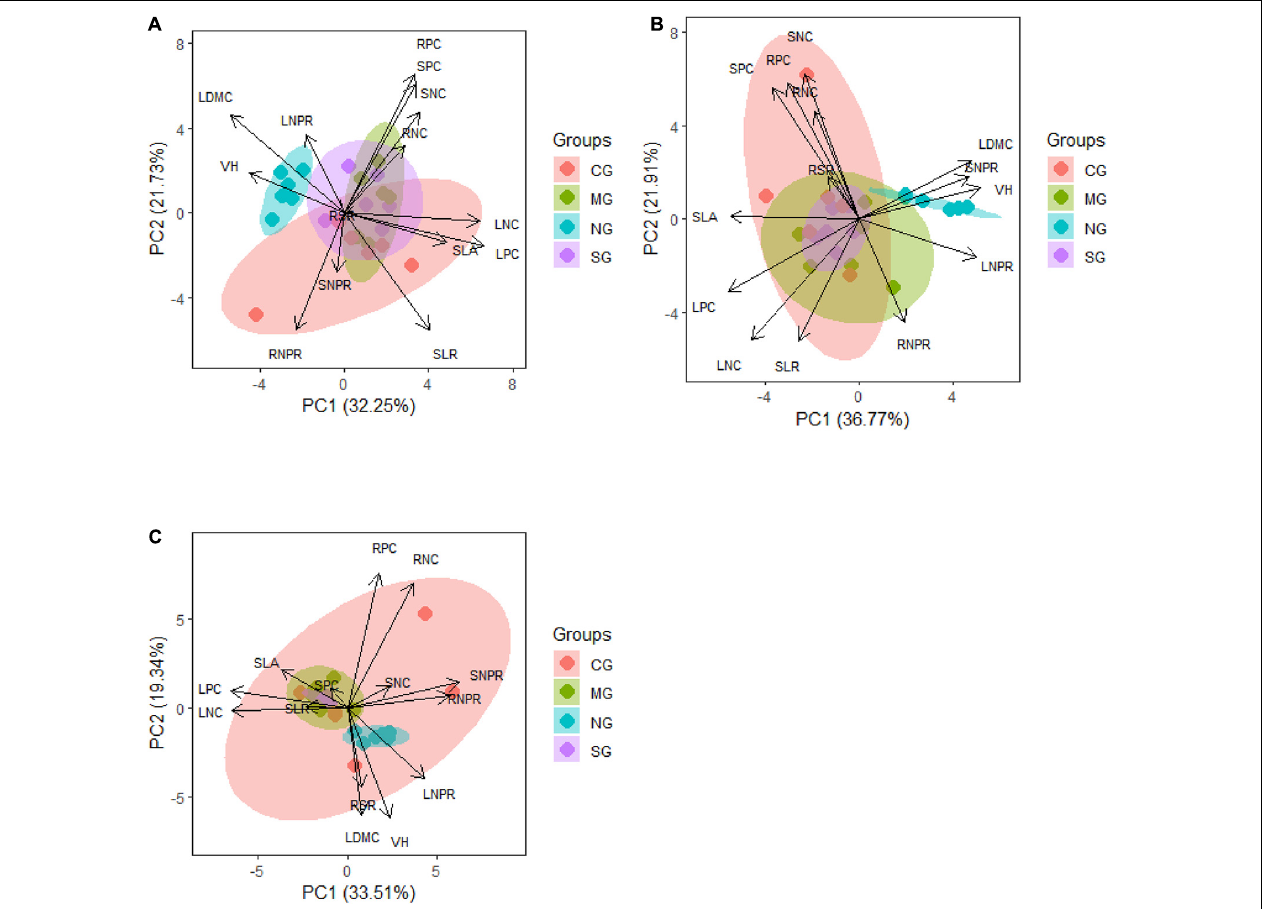
FIGURE 3 | PCA of plant functional traits within Stipa grandis (A) , L. chinensis (B) , and Cleistogenes squarrosa (C) . Plot CG means cattle grazing; plot SG means sheep grazing; plot MG means mixed grazing of cattle and sheep; and NG means no grazing. VH denotes vegetative height; SLR indicates stem-to-leaf ratio; RSR represents root biomass over aboveground biomass; LDMC denotes leaf dry matter content; SLA indicates specific leaf area; RNC represents root nitrogen content; RPC denotes root phosphorus content; RNPR indicates root nitrogen to phosphorus ratio; SNC represents stem nitrogen content; SPC denotes stem nitrogen content; SNPR indicates stem nitrogen content; LNC represents leaf nitrogen content; LPC denotes leaf phosphorus content; and LNPR indicates leaf nitrogen phosphorus